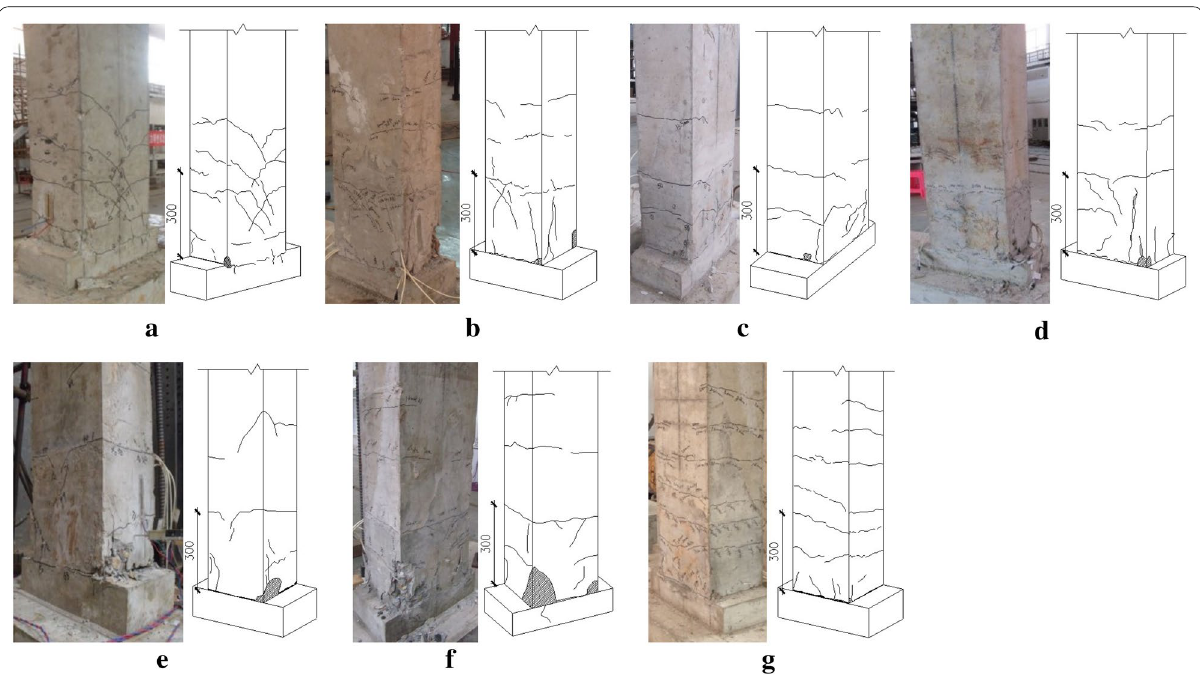
Fig. 6 Distribution of cracks of the test specimens a BASE; b ZP1; c ZP2; d ZP3; e ZP4; f ZP5; g